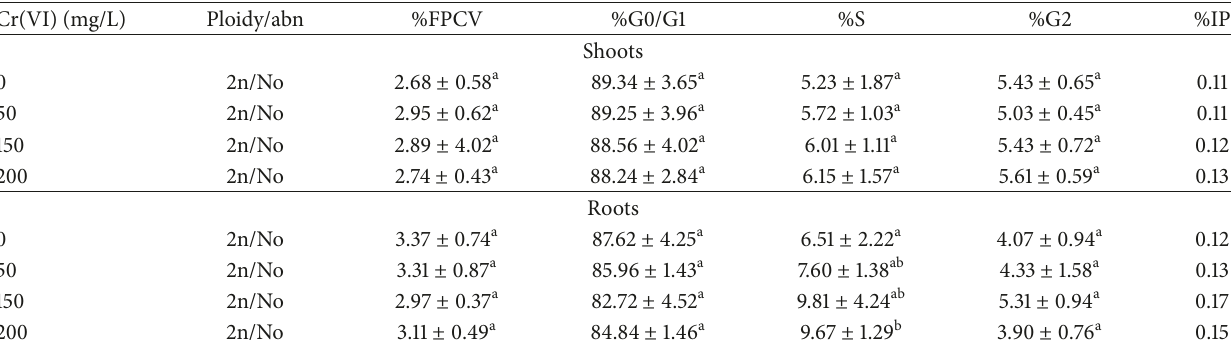
Figure 2: Tail DNA (TD) (%) and tail moment (TM) in (a) roots and (b) leaves exposed to Cr(VI). Different letters indicate for the same parameter significantly different means between control and stressed individuals ( 𝑝 < 0.05 ). Table 2: Flow cytometry data for roots of L. sativa L. plants exposed to Cr(VI). Values are presented as the mean ± coefficient of variation. Different letters indicate for the same parameter significantly different means ( 𝑝 < 0.05 ).